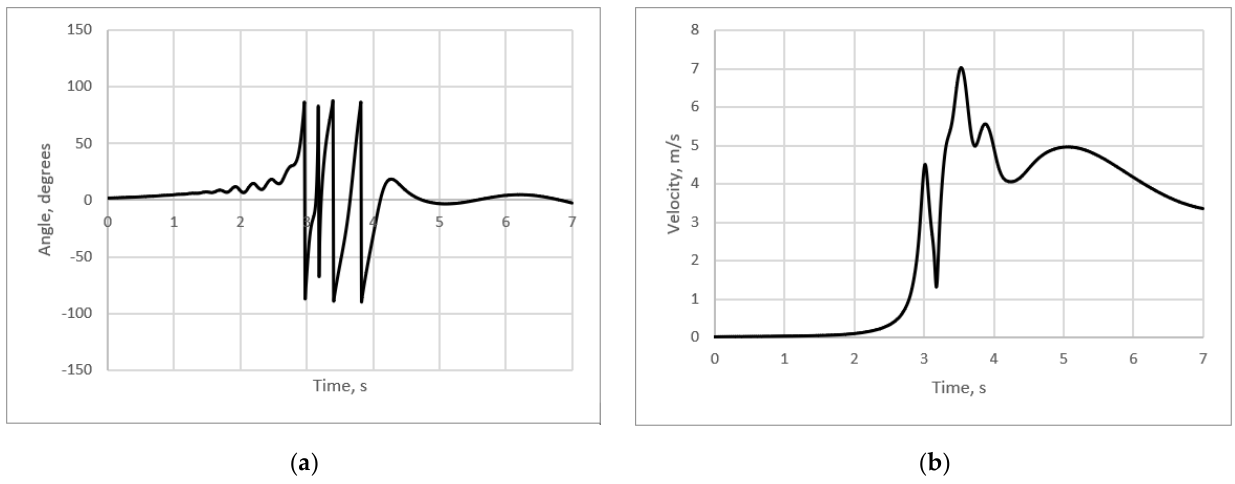
Figure 11. Velocity contour at (cid:1872) = 7(cid:1871) using medium mesh density.